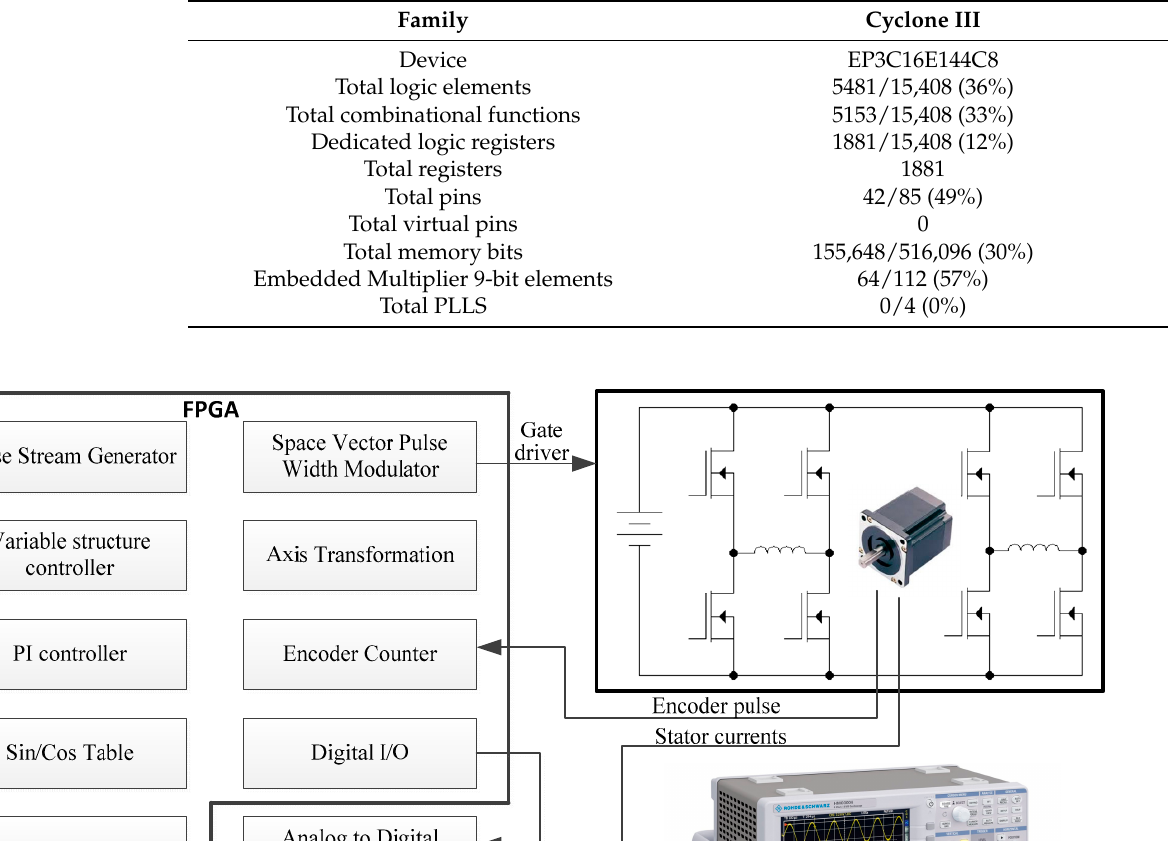
Figure 16. The built functions of FPGA and signal flow diagram of experiment system. The experimental results with step position command input are shown in Figure 17. The system takes about 100 ms to reach its steady-state value as simulated, and the speed response is not so sharp as the simulation. Table 2. The usage of chip to realize the drive system.